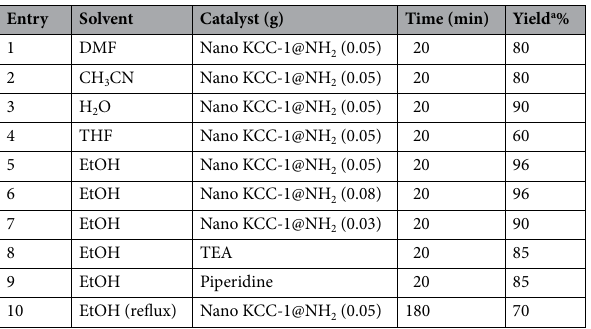
Table 1. Optimization of reaction condition for the formation of 2-amino-4H-chromenes. Reactions conditions: p-chloro benzaldehyde (1 mmol), 1,5-naphtalendiol (0.05 mmol), malononitrile (1 mmol). Ultrasonic irradiation (80 W). a Isolated yield.